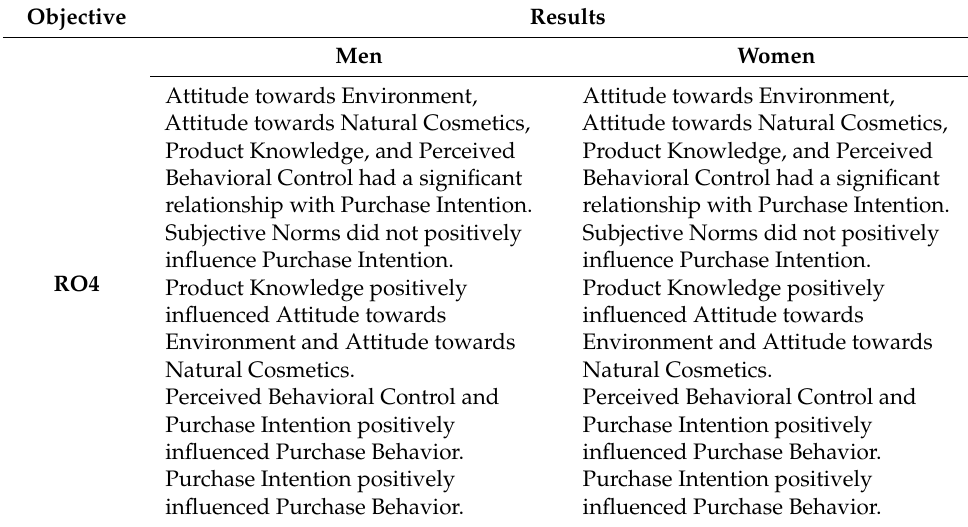
Figure 3. Structural model constructed using SmartPLS. Figure 2. Structural model constructed using SmartPLS. Table 5. Comparison of results between men and